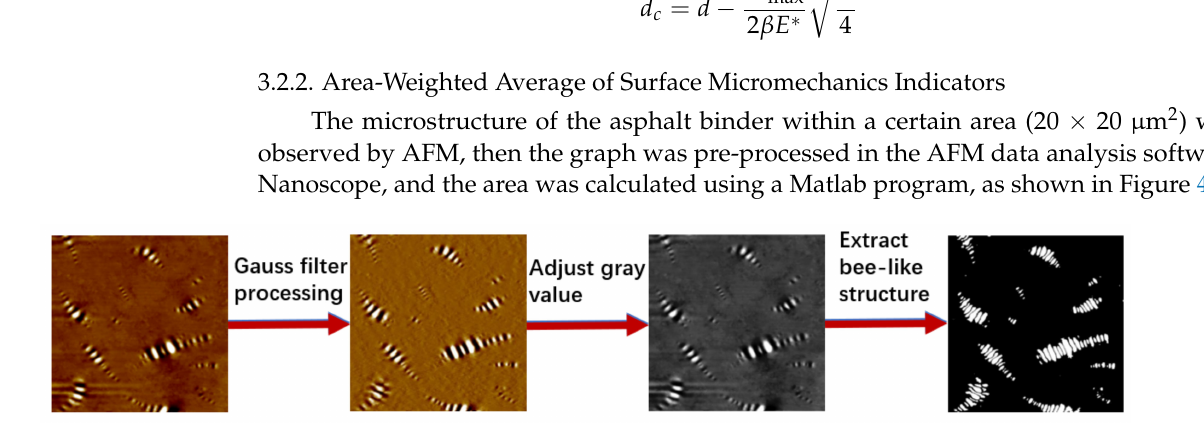
Figure 4. Image Processing of Bee-like Structure.